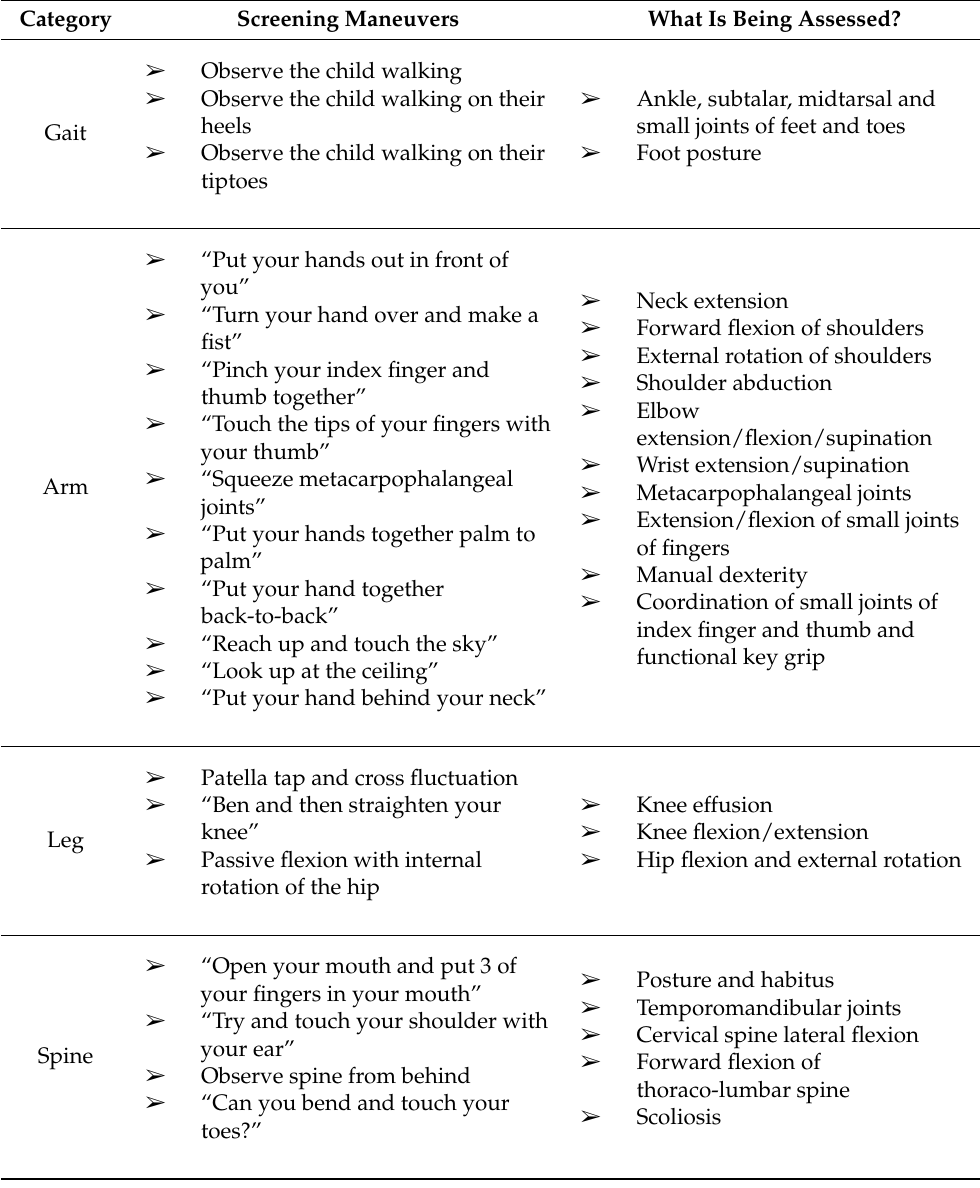
Table 1. The pGALS